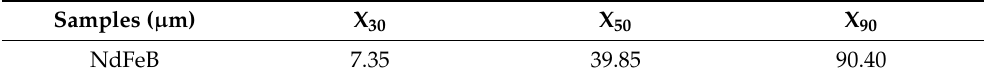
Table 3. Particle size analysis of the NdFeB powders after demagnetizing, grinding, and